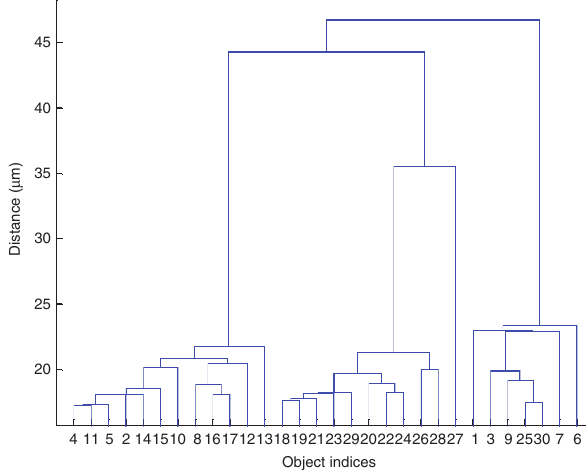
Figure 4: Hierarchical cluster tree (dendrogram) for zoned arrangement.